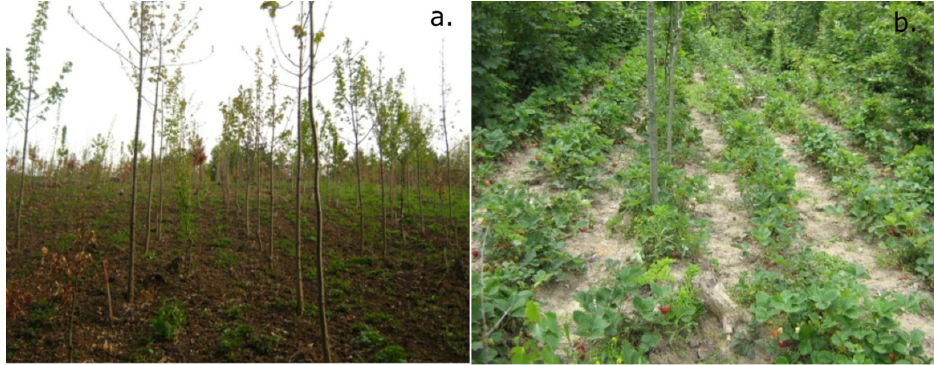
Figure 2. Agroforestry system used for the first 5 years of the stand. ( a ) Spring,( b ) summer.